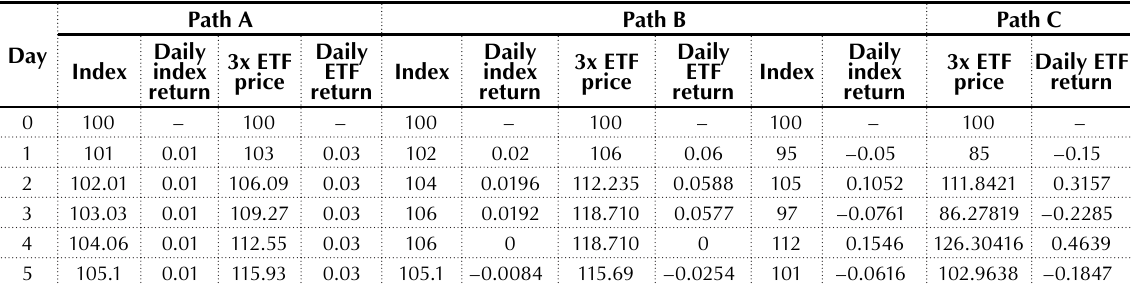
Table 2. Different index paths – different LETF